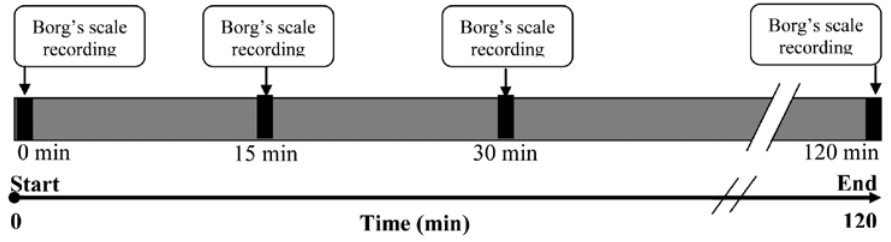
Figure 3 - Schematic schedule of measurement including: 1) The total period of time; 2) Borg’s scale recording at every 15 min time period.